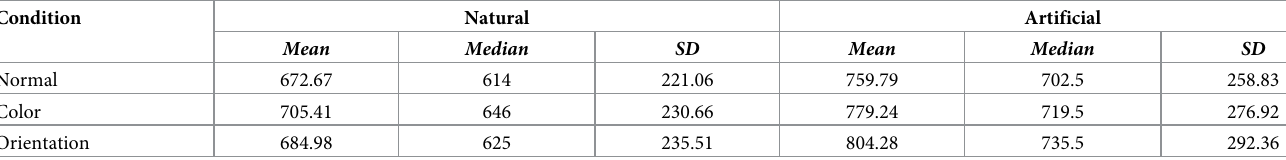
Table 3. Raw RT means, medians, and standard deviations for condition x category.